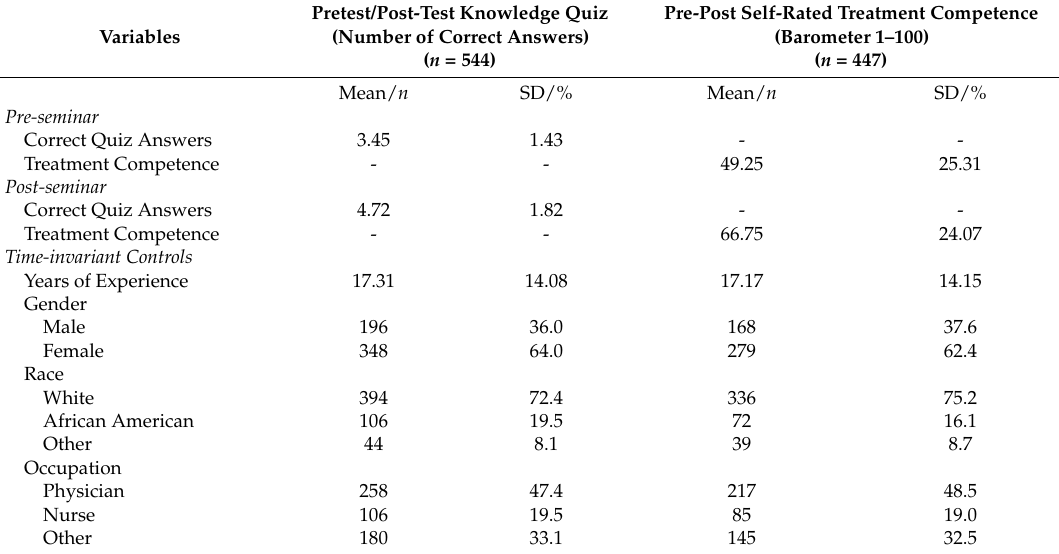
Table 2. Developmental Evaluation, Training and Consultative Team (DETECT) Seminar Attendee Descriptive